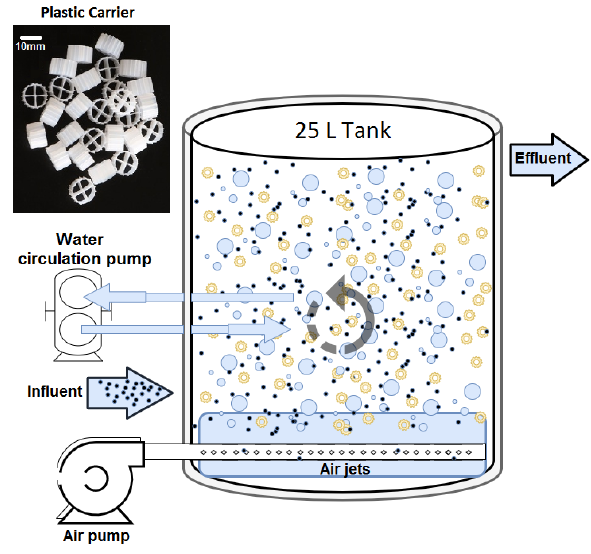
Figure 1. The experimental MBBR system